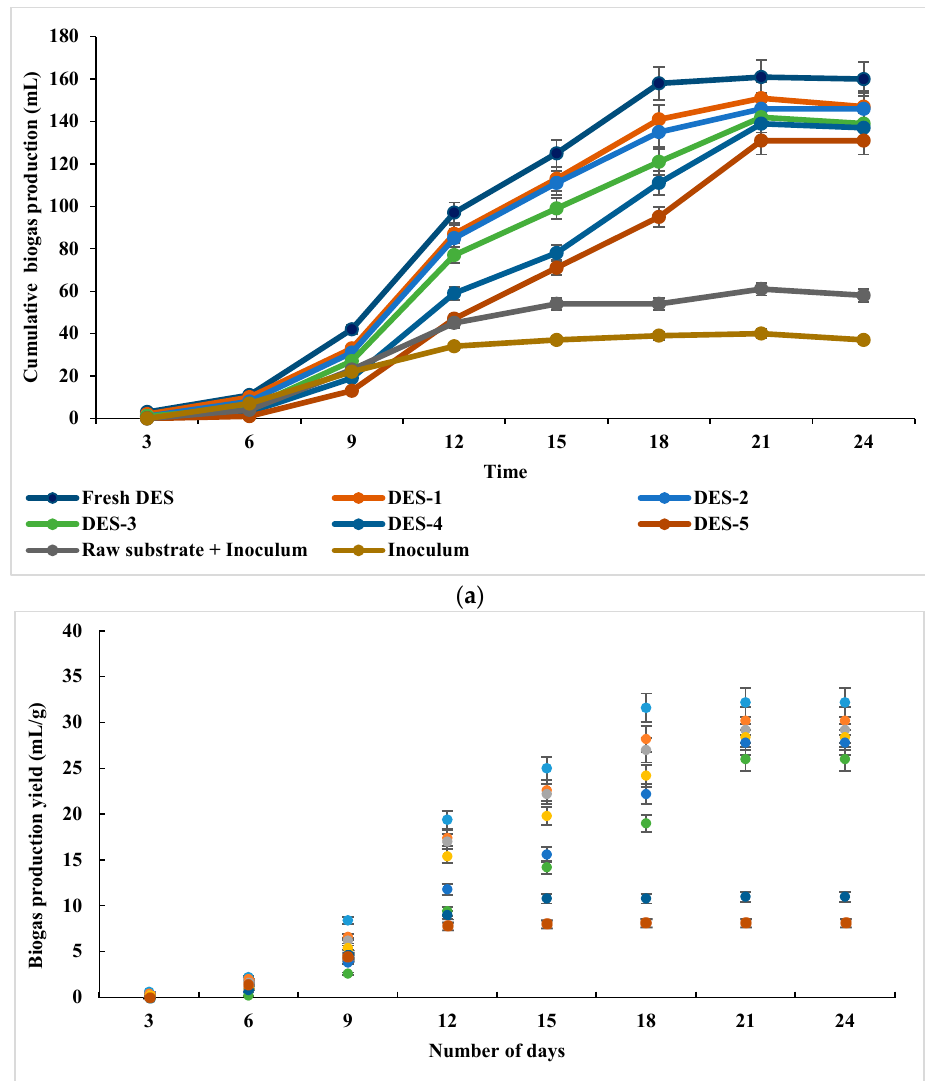
Figure 6. ( a ) Cumulative biogas production (mL) from fresh and recycled ChCl: LA DES-pretreated halophyte samples. ( b ) Biogas production yield (mL/g) of fresh and recovered ChCl: LA DES- pretreated Atriplex crassifolia